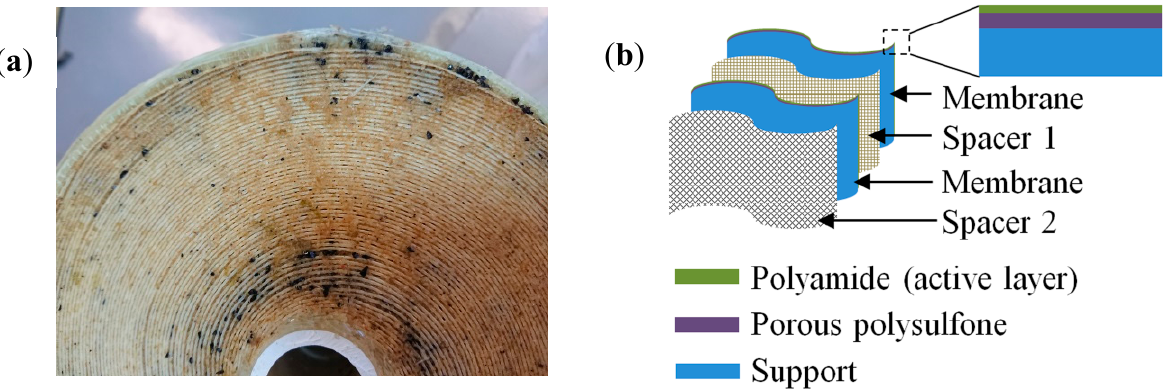
Figure 3. ( a ) Optical image of the cross-section of fouled spiral RO membrane cartridge. ( b ) A schematic representation of RO membrane arrangement and structure used in this work.